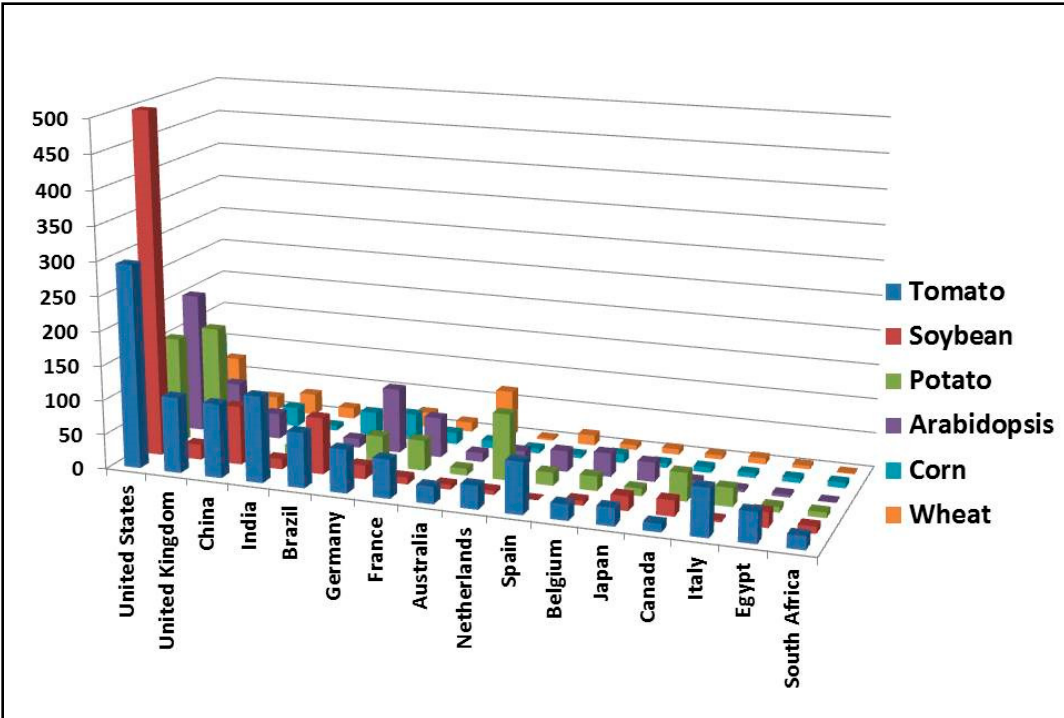
Figure 5. Relationship between crops and the countries with the highest scientific production of nematodes + plants.